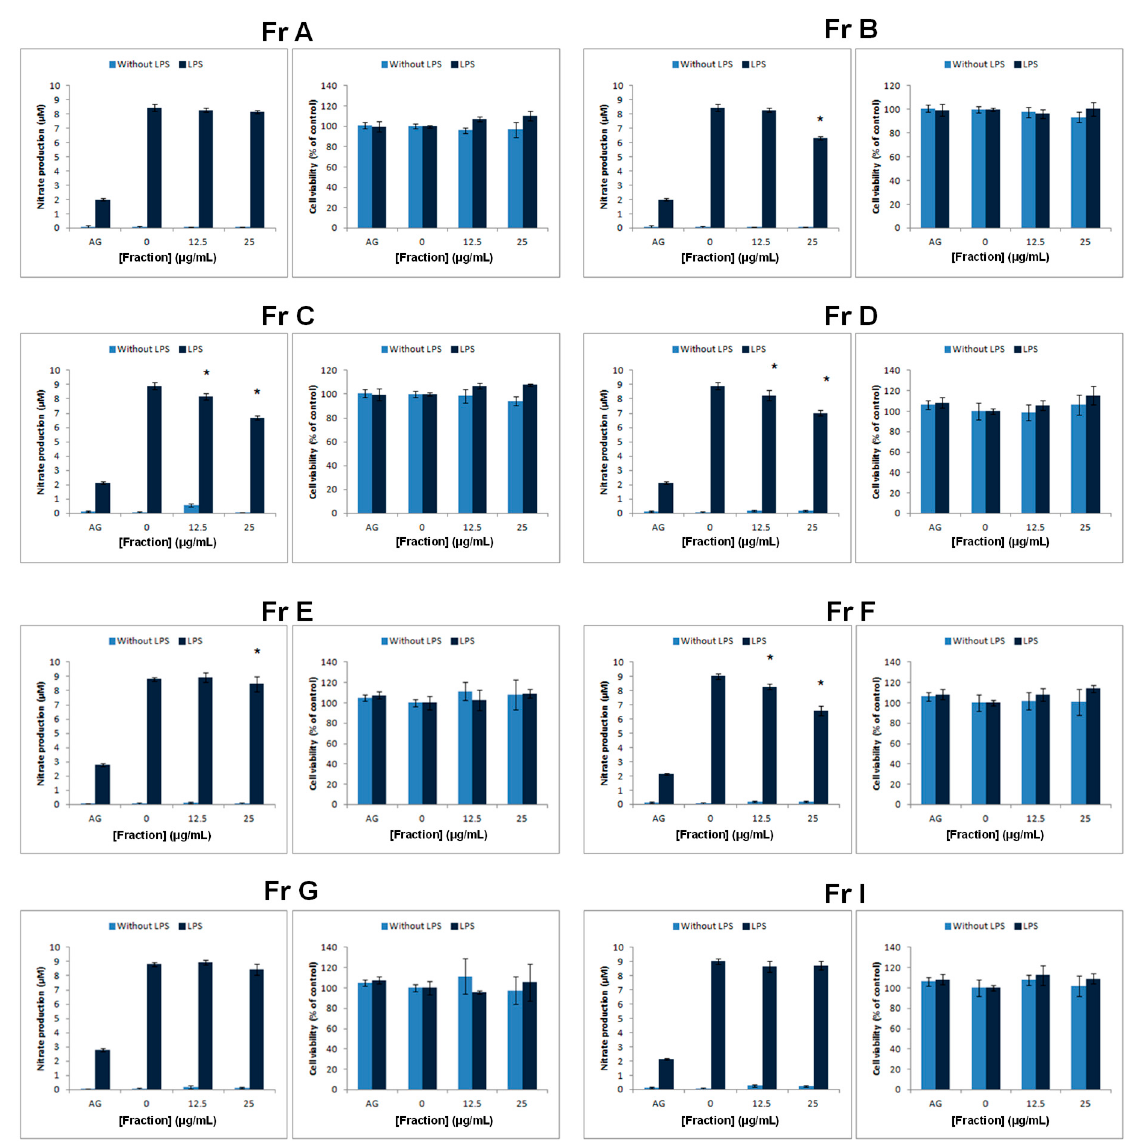
Figure 2. Nitrate production in LPS activated and naïve RAW 264.7 macrophages treated with